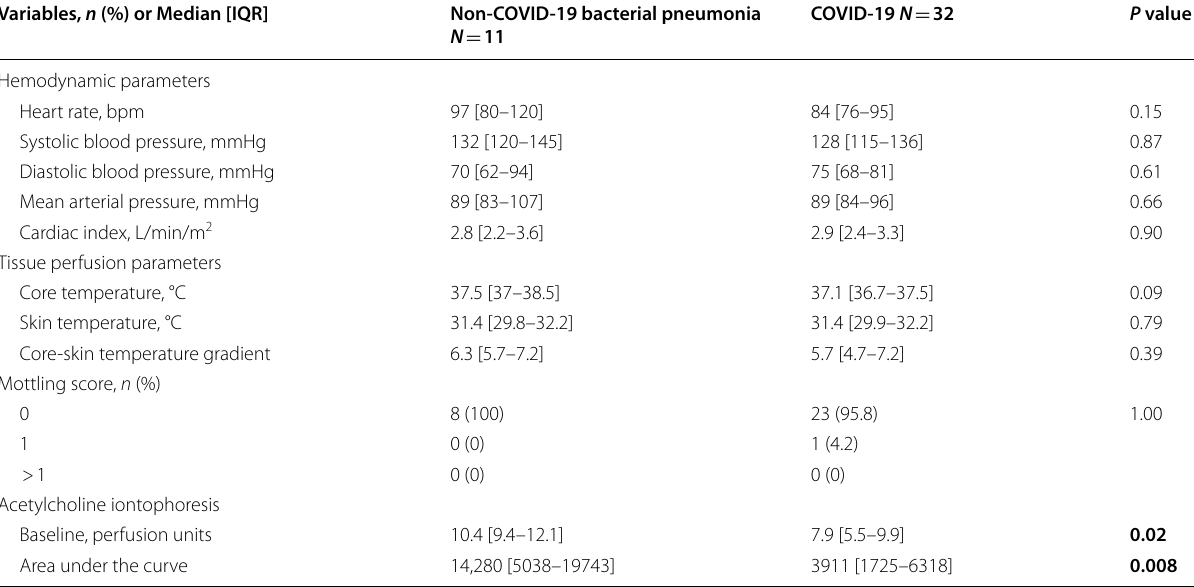
Table 2 Global hemodynamic, tissue perfusion and iontophoresis parameters Variables, n (%) or Median